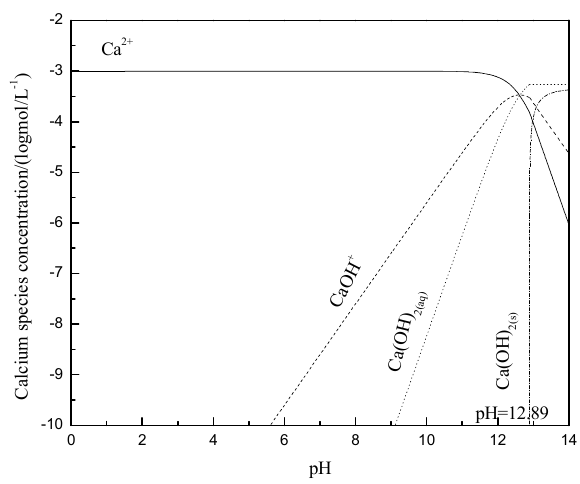
Figure 7. Calculated concentration of calcium species in solution with 1 × 10 − 3 mol/L Ca 2+ .